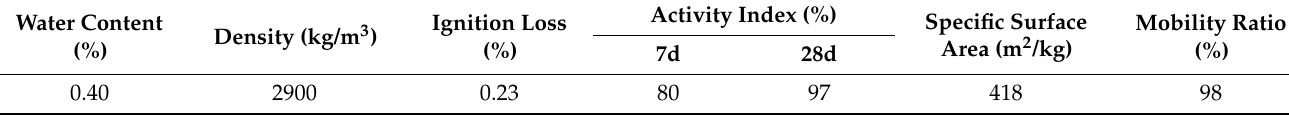
Table 3. Material properties of blast furnace slag